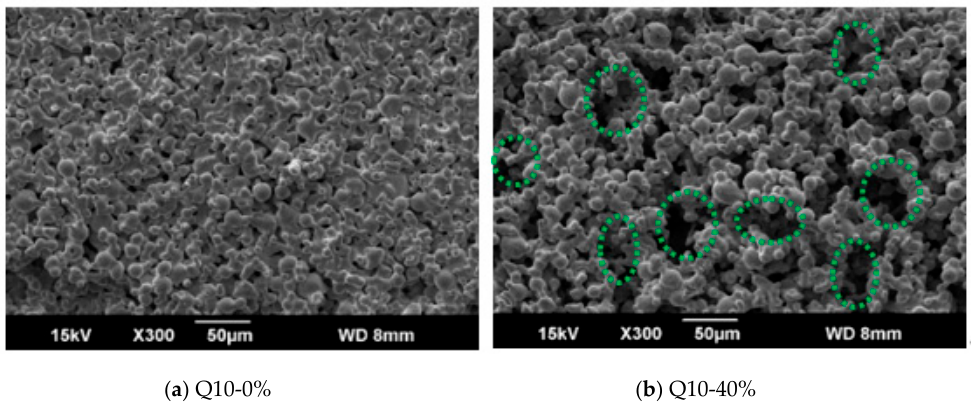
Figure 5. Electron micrographs of porous microchannels with pore-forming agent. Green dotted circle represent large void created by PFA.